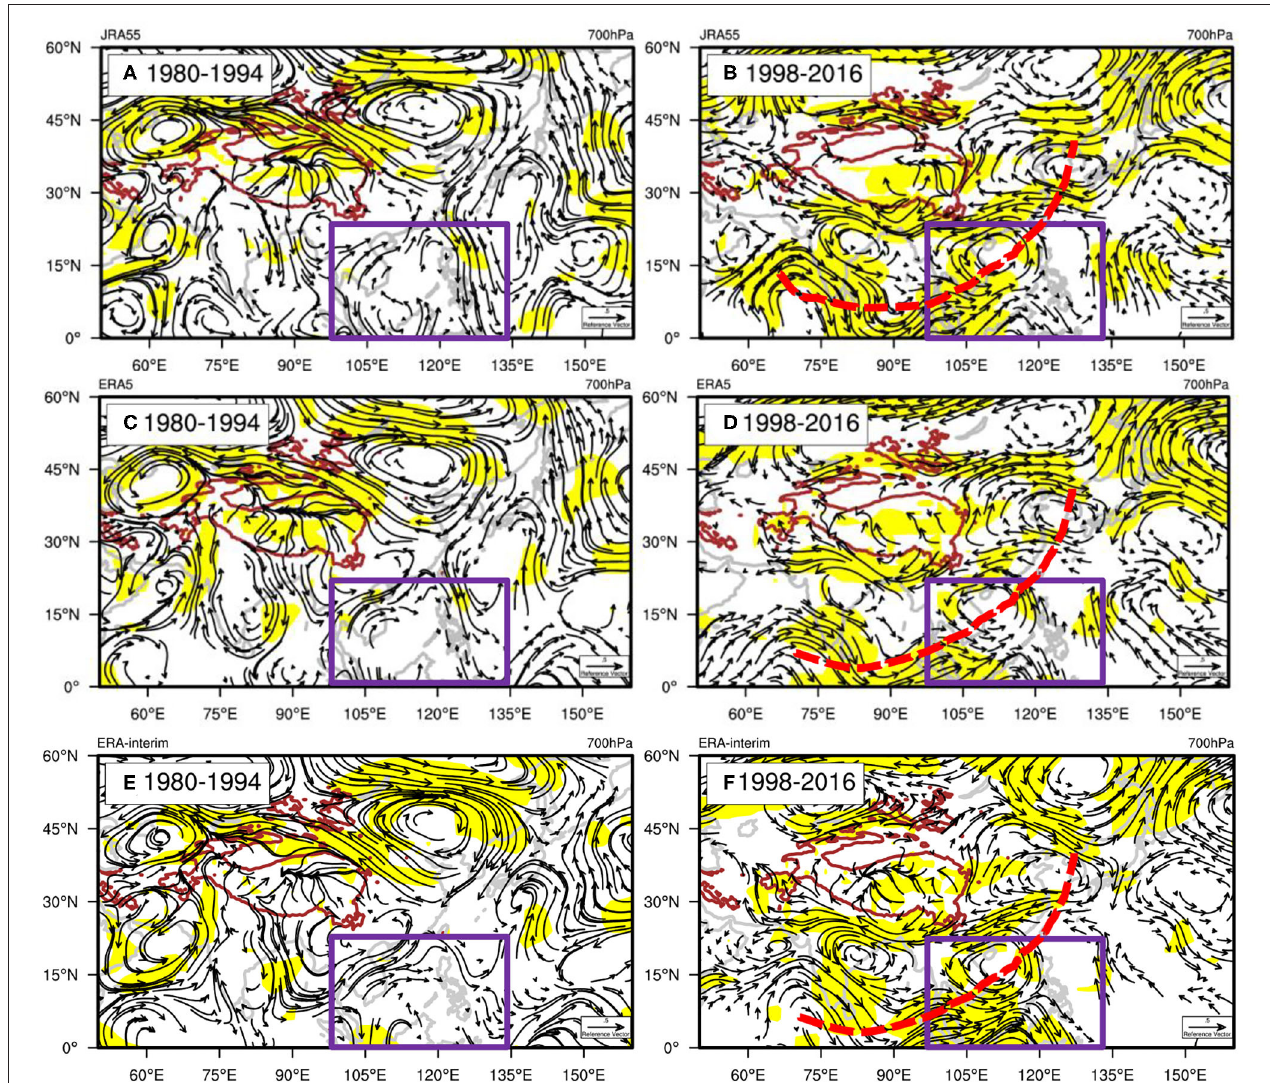
FIGURE 7 | Standardized partial regression coefficients between Tibetan Plateau temperature and wind field at 700 hPa in East Asia: (A,C,E) for the period from 1980 to 1994 and (B,D,F) for the period from 1998 to 2016. (A,B) Based on JRA55; (C,D) based on ERA5; and (E,F) based on ERA–Interim. Red solid line represents the Tibetan Plateau. The purple boxed areas represent the South China Sea. Red dashed lines represent wave–like structures. Hence, the area where the averaged altitude above 3,000 m is already masked. Vectors are ignored for values < 0.20. Shading indicates significant differences above the 90% confidence level based on the Student’s t